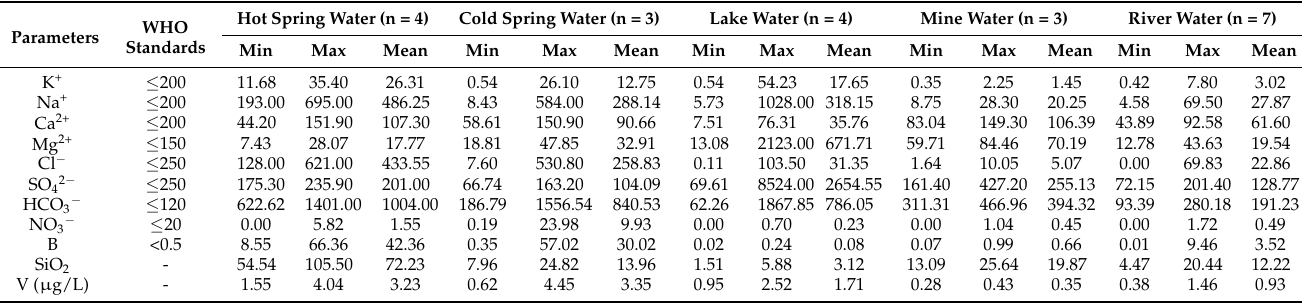
Table 2. Statistical results of chemical parameters for different water types in the study area (unit: